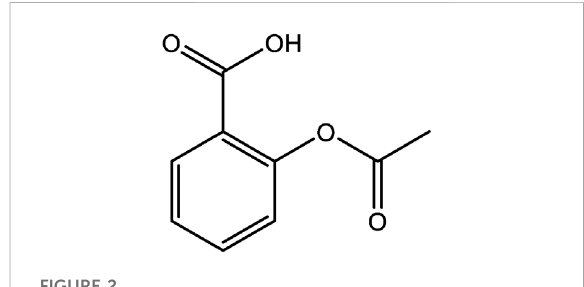
FIGURE 2 The chemical structures of Aspirin.